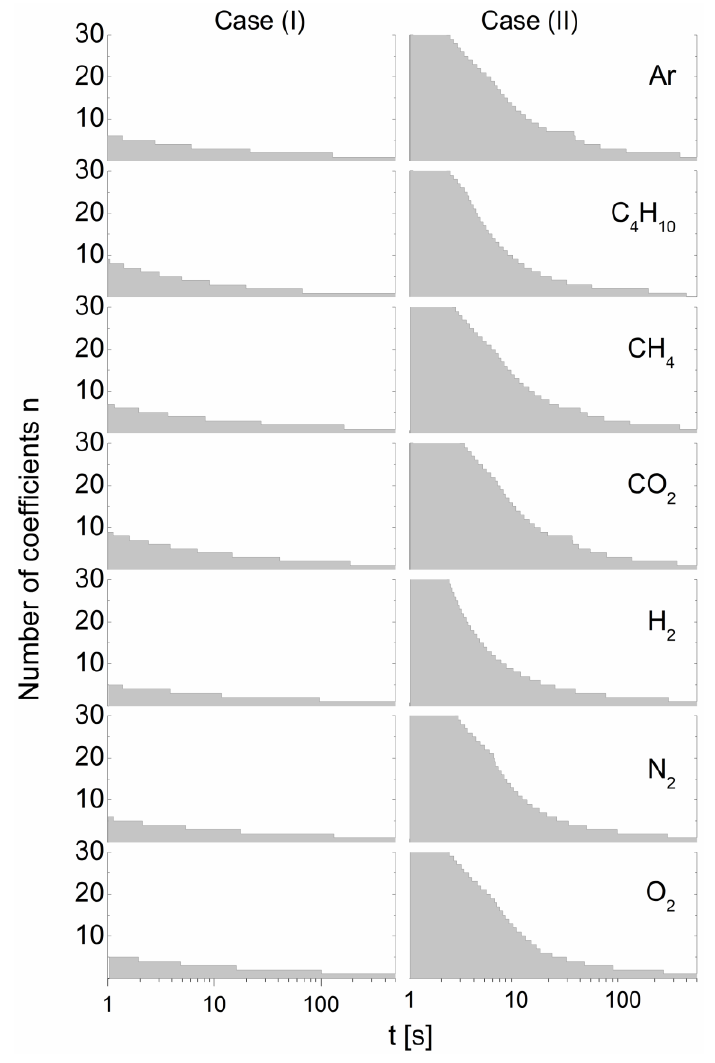
Figure 6. Time dependency of the number of terms n in Equation (10) necessary to satisfy the quality criterion 01.0  in Equation (13). The gas sensor pair consisted of cell I and cell